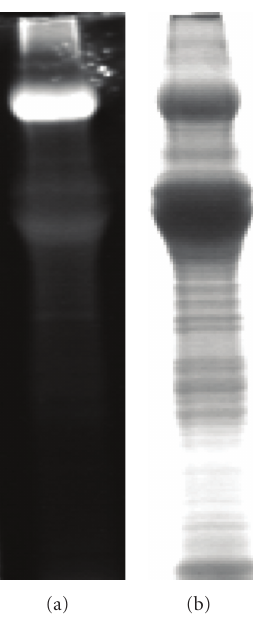
Figure 4: (a) LRSH staining of prefractionated pregnancy urine in SDS-PAGE. (b) Poststained with Coomassie blue. A total of 1mL of pregnancy urine was utilized for prefractionation and SDS-PAGE